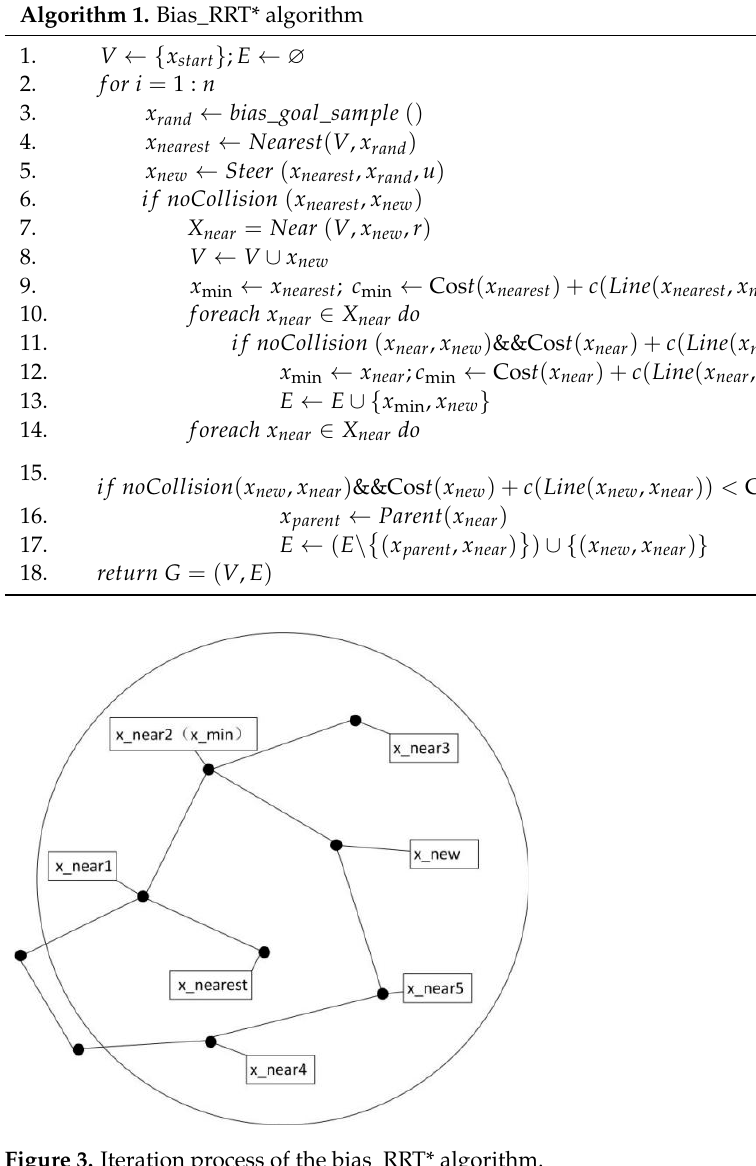
Figure 3. Iteration process of the bias_RRT*